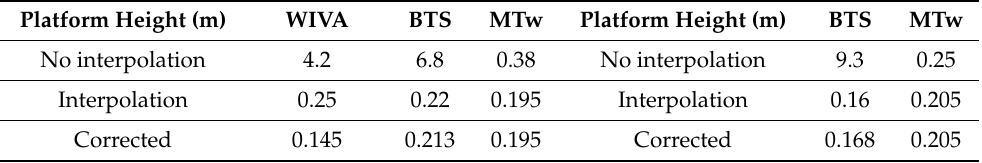
Table 2. Platform height. Male results to the left; female results to the